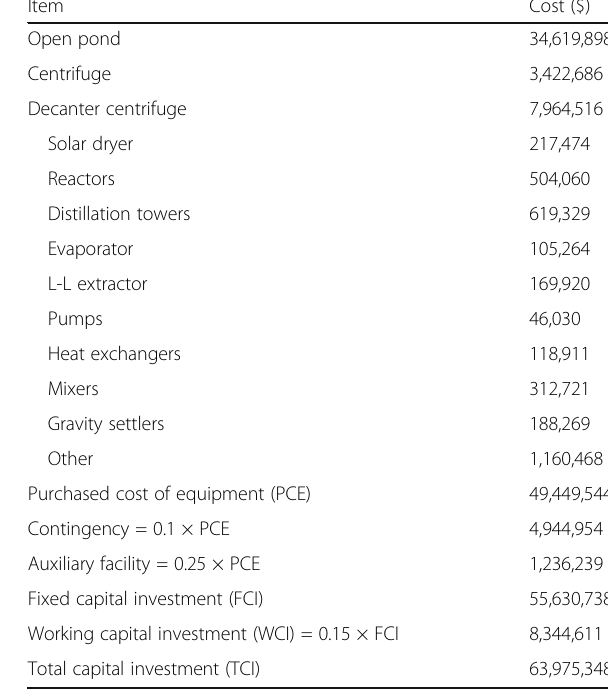
Table 5 Equipment costs, fixed capital costs, and total